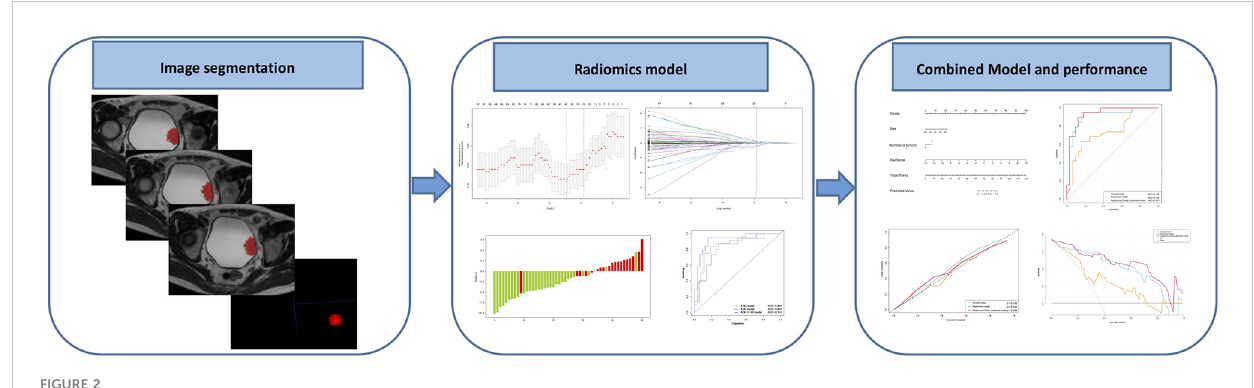
FIGURE 2 Radiomics work fl ow and study fl